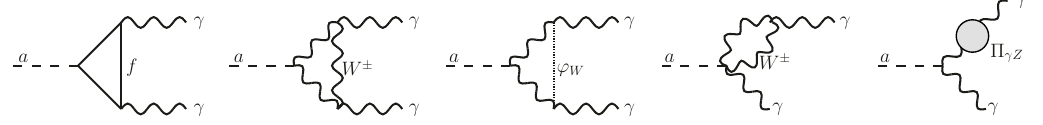
(cid:13)(cid:13) . The !